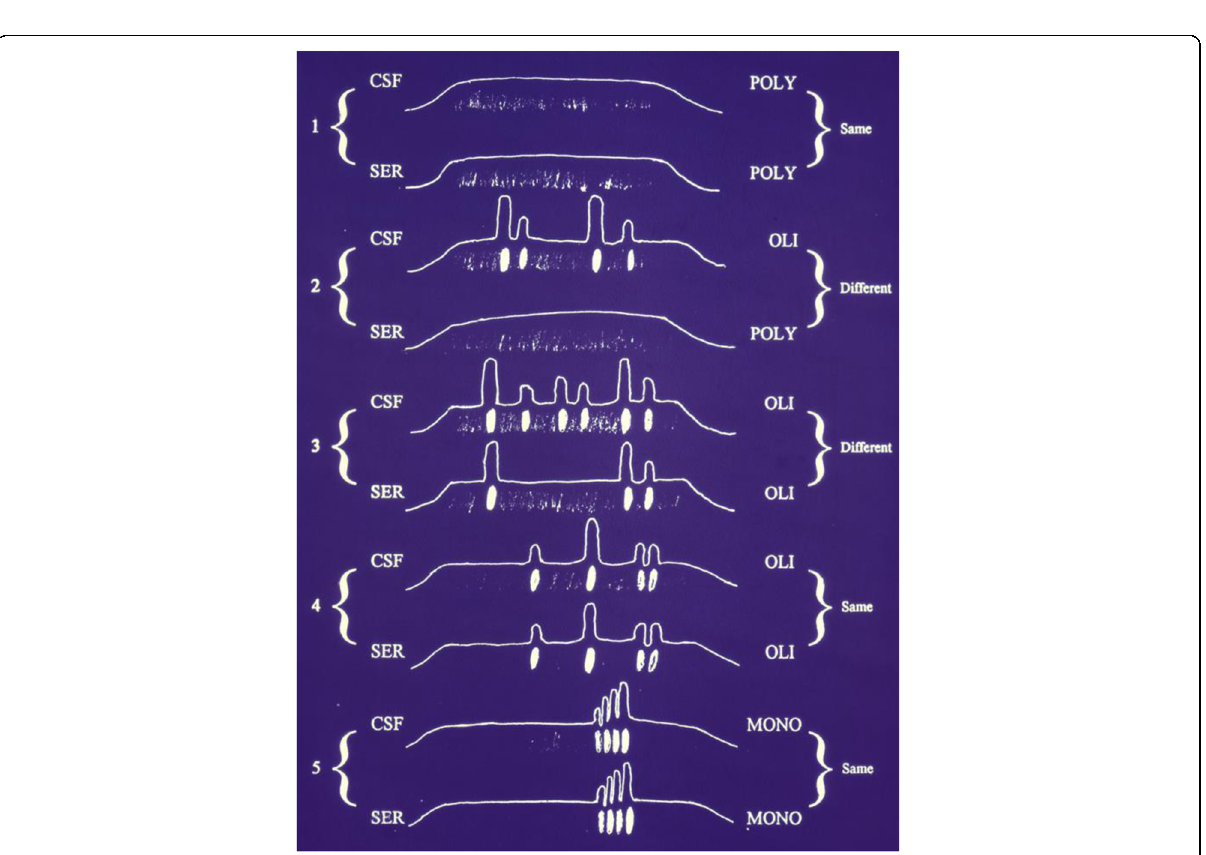
Fig. 4 IgG band patterns illustrated graphically. Abbrev.: CSF, cerebrospinal fluid;, Ser, serum; Poly, polyclonal; Oli, oligoclonal; Mono, monoclonal